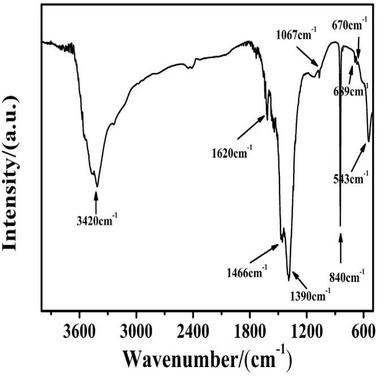
FTIR spectrum of Bi2O2CO3.